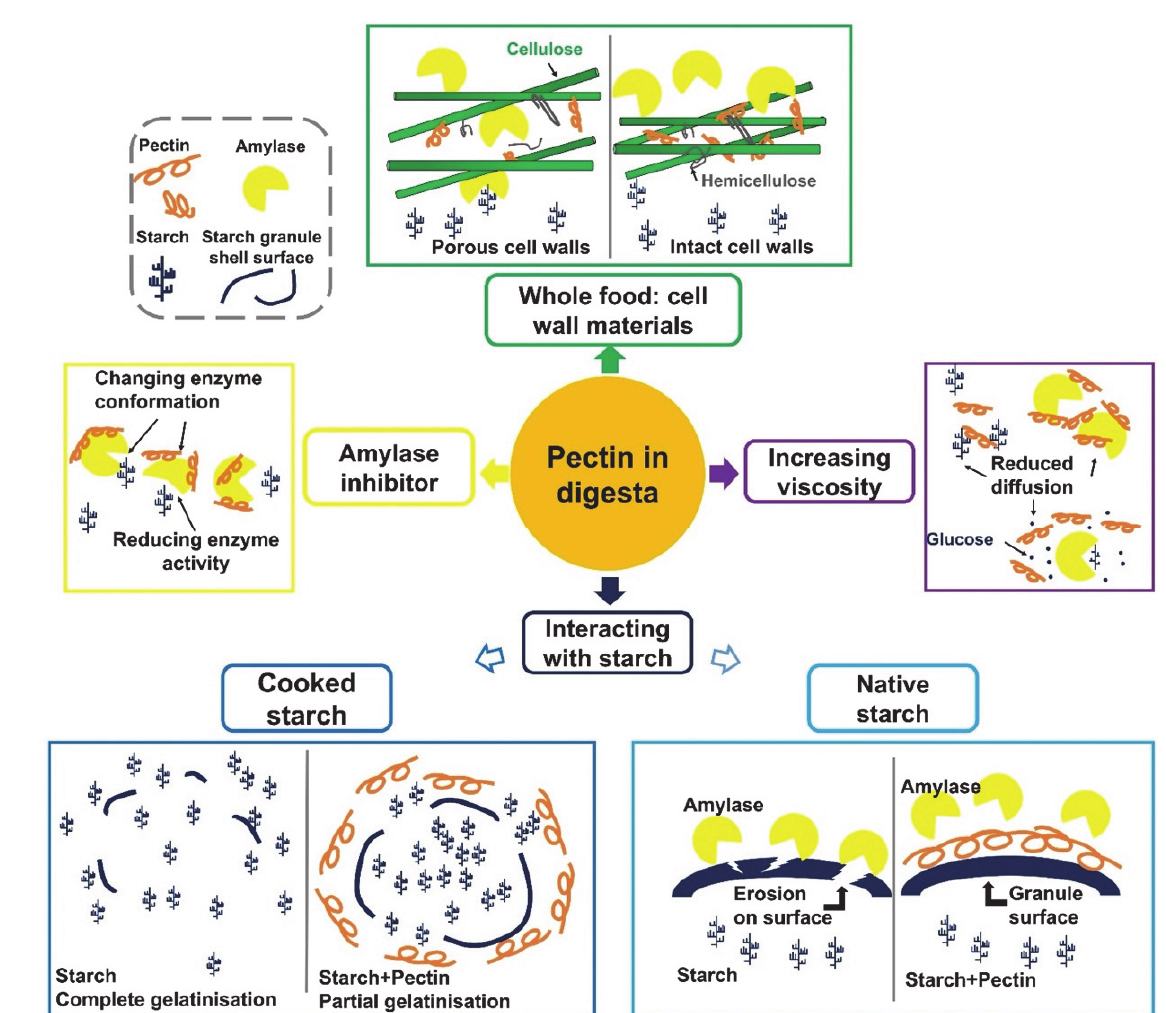
Figure 3. Schematic figure of pectin’s functions and mechanisms in regulating starch digestion process under in vitro conditions.